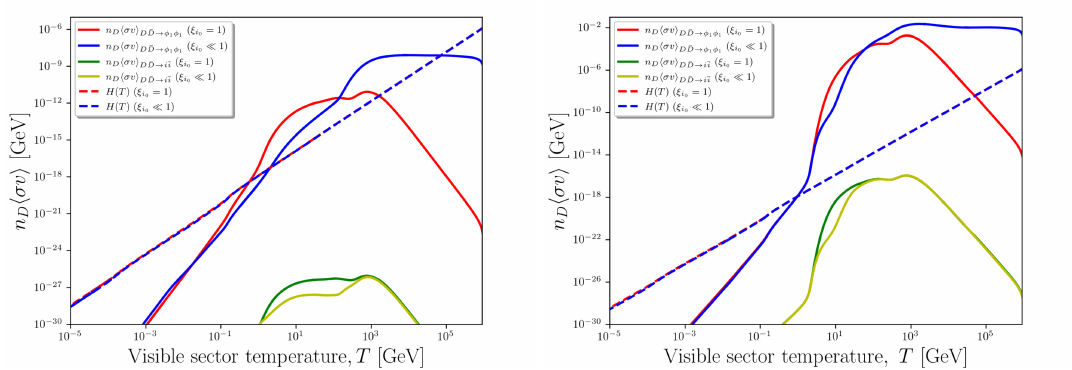
Figure 7. Display of n D h σv i for the processes D ¯ D → φ 1 φ 1 and D ¯ D → i ¯ i versus T for two cases: ξ i = 1 and ξ i 6 = 1 . Input parameters for the left panel are: m D = 9 . 0 GeV, m φ 0 0 m φ = m φ = 1 MeV, y f = 4 . 5 × 10 − 10 , y D = 0 . 13 and κ 1 = κ 2 = 5 × 10 − 8 . Input parameters for 2 3 the right panel are: m D = 5 . 0 GeV, m φ and κ 1 = κ 2 = 1 × 10 − 5